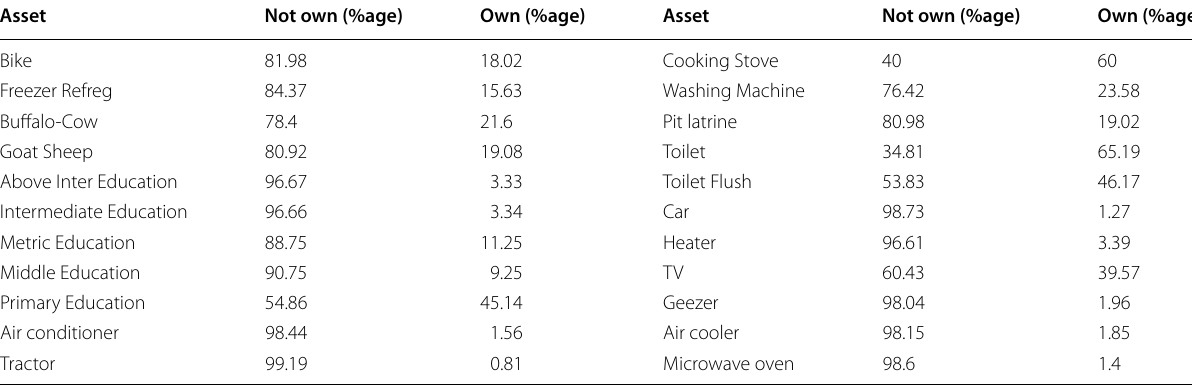
Table 3 Percentage distribution of household assets in Pakistan. Source : Author’s calculation Asset